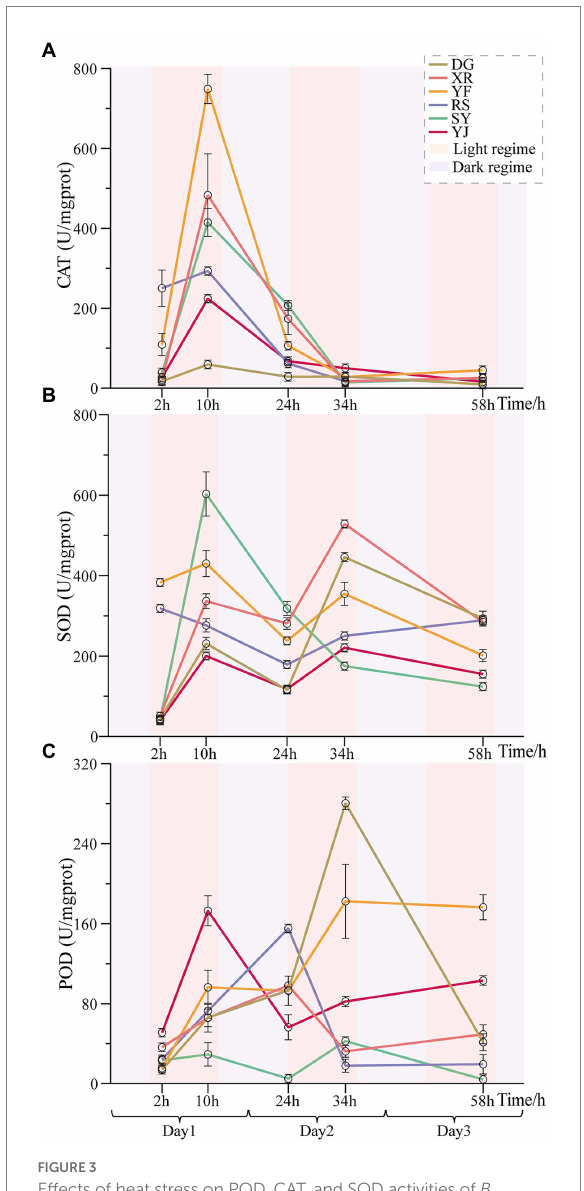
FIGURE 3 Effects of heat stress on POD, CAT, and SOD activities of B. luminifera populations under different temperature treatments times. (A) The change pattern of SOD activities. (B) The change pattern of POD activities. (C) The change pattern of CAT activities. Error bars indicating standard error